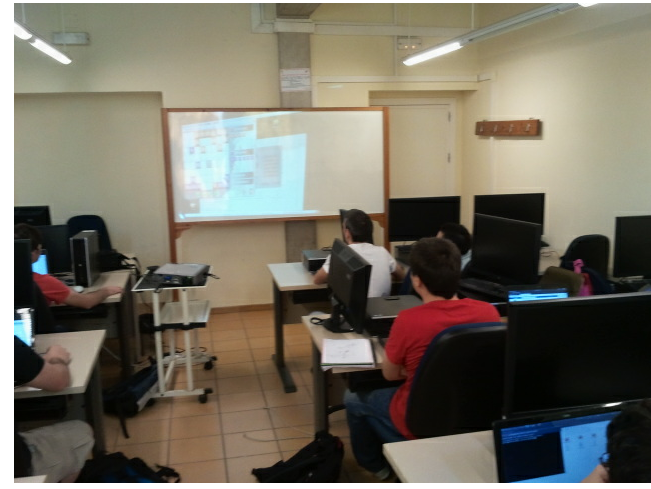
Figure 3. Students watching a